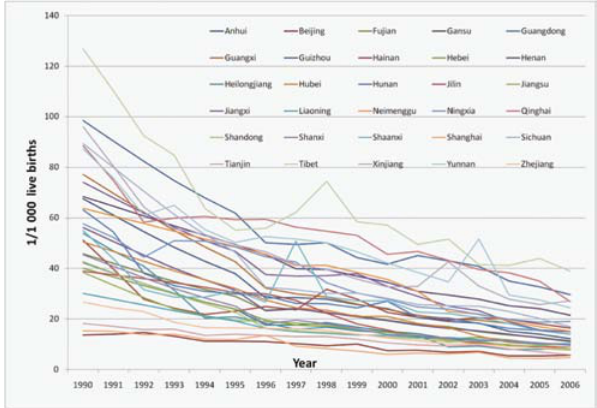
Figure 2 Trends of U5MR by provinces in China